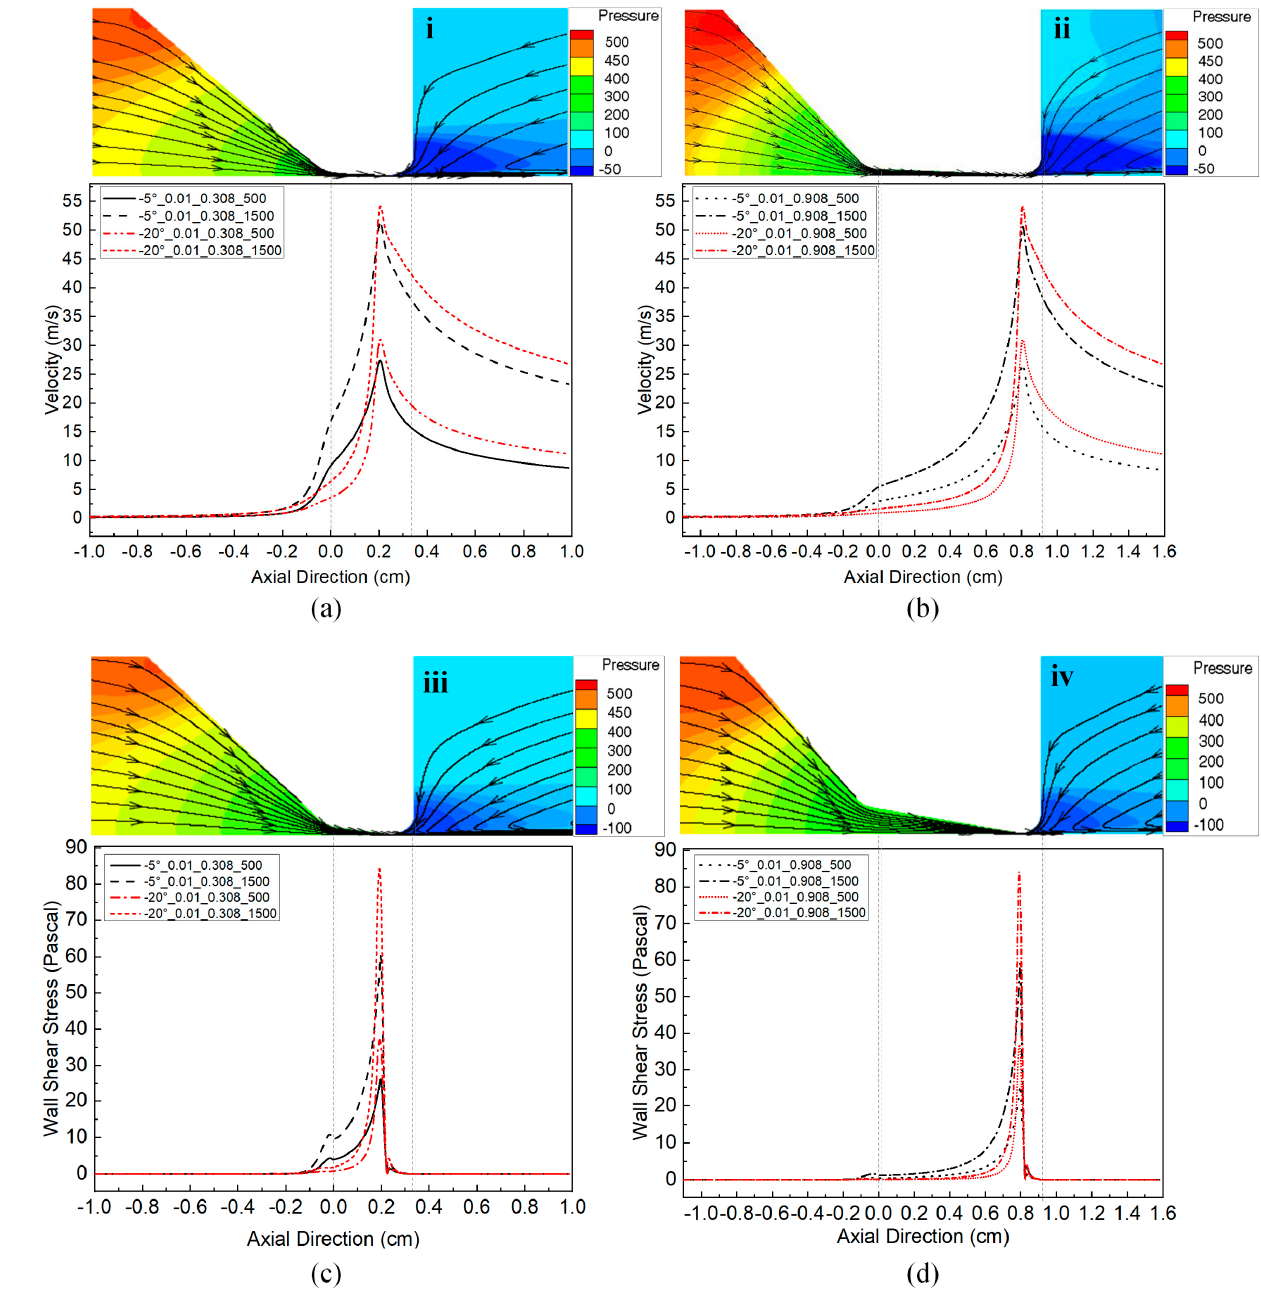
Figure 9. (Color online) Schematic of glottal configurations, the corresponding velocity magnitude distributions on the centerline of the glottis, and the corresponding wall shear stress distributions for 0.01 cm minimal glottal diameter, 0.308 cm and 0.908 cm vertical glottal duct lengths, 500 Pa and 1500 Pa transglottal pressures, and − 5° and -20° convergent glottal angles. The upper portion of each figure shows the outlines of the glottal configurations as well as the velocity vector streamtraces and the contour levels of intraglottal pressures (via the red-to-blue coloring): (i) − 5° glottal angle, 0.01 cm minimal diameter, 0.308 cm glottal duct length, 500 Pa transglottal pressure; (ii) − 5° glottal angle, 0.01 cm minimal diameter, 0.908 cm glottal duct length, 500 Pa transglottal pressure; (iii) − 20° glottal angle, 0.01 cm minimal diameter, 0.308 cm glottal duct length, 500 Pa transglottal pressure; (iv) − 20° glottal angle, 0.01 cm minimal diameter, 0.908 cm glottal duct length, 500 Pa transglottal pressure. The lower portions show the corresponding velocity magnitude distributions ( a , b ) and wall shear stress distributions ( c , d ).